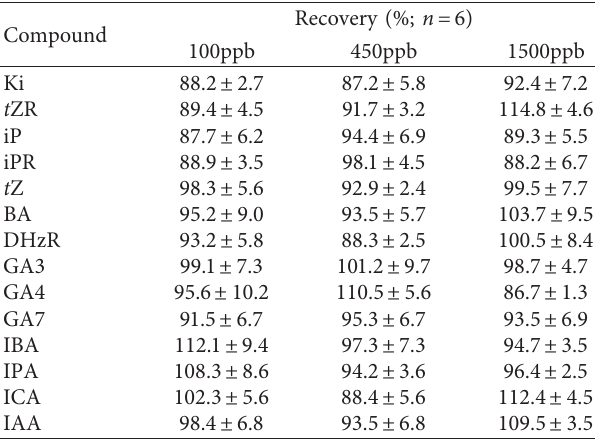
Table 1: Recoveries of fourteen phytohormones spiked into algal extract samples ( n �